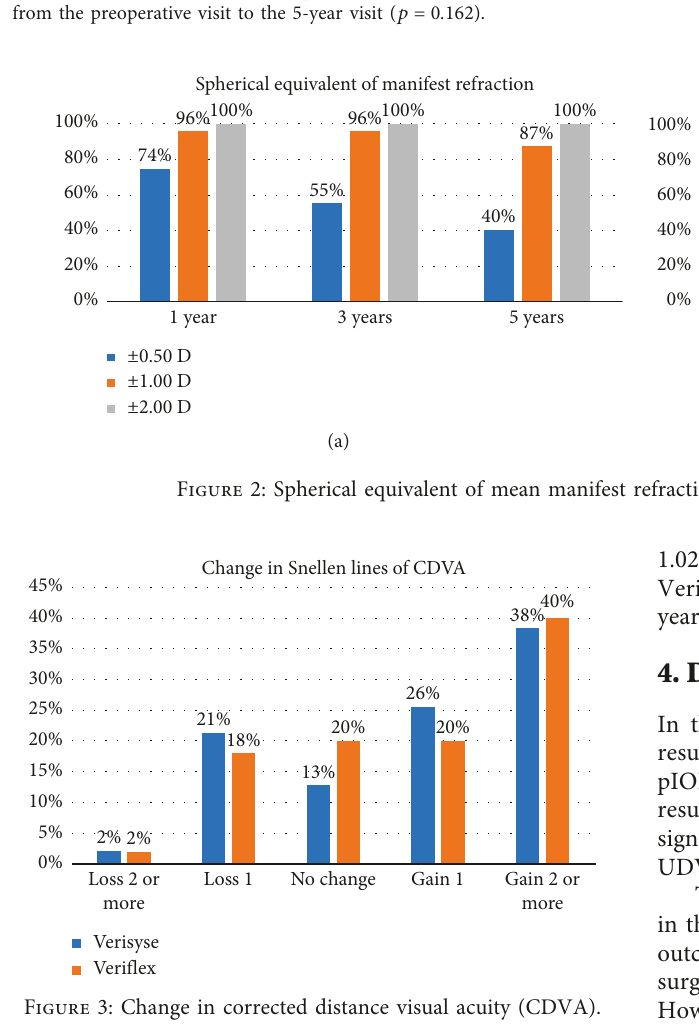
Repeated measures ANOVA, p value for all visits.